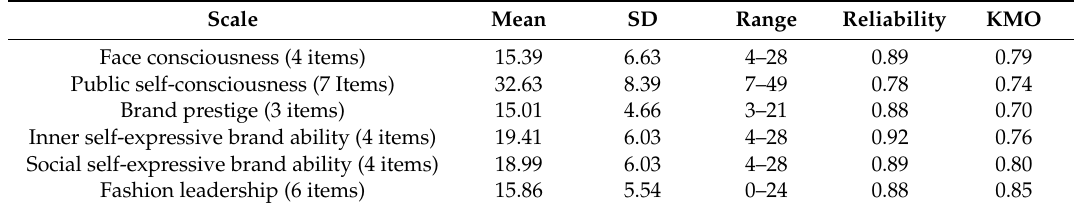
Table 1. Descriptive statistics and reliability for variables used in study.